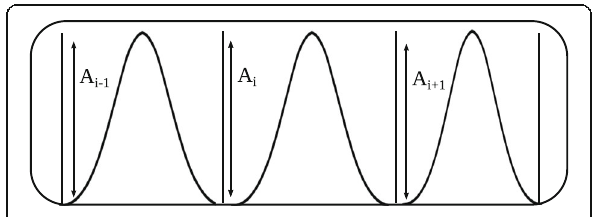
Fig. 2 Absolute shimmer measurement for N = 3 pitch periods